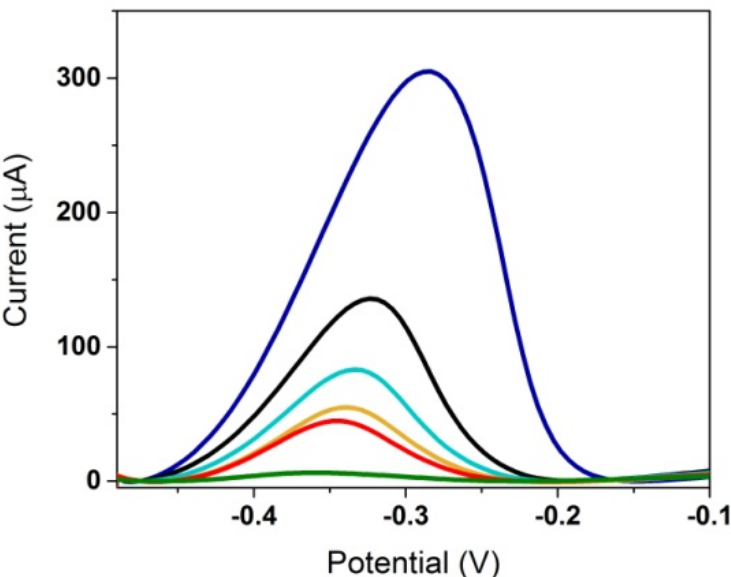
Figure 6. DPV characterization in 10 mM PBS pH 7.4 after 30 min incubation with 0.5 mM MB of the C-SPE/AuNPs/MCH ( green ); after 30 min incubation with 0.5 mM MB of the C- SPE/AuNPs/APT/MCH ( blue ); after 30 min incubation of the MB-labeled aptasensor with blank ( black ); 1 µM 3-O-C 12 -HSL ( cyan ); 10 µM 3-O-C 12 -HSL ( orange ); or 50 µM 3-O-C 12 -HSL ( red ).